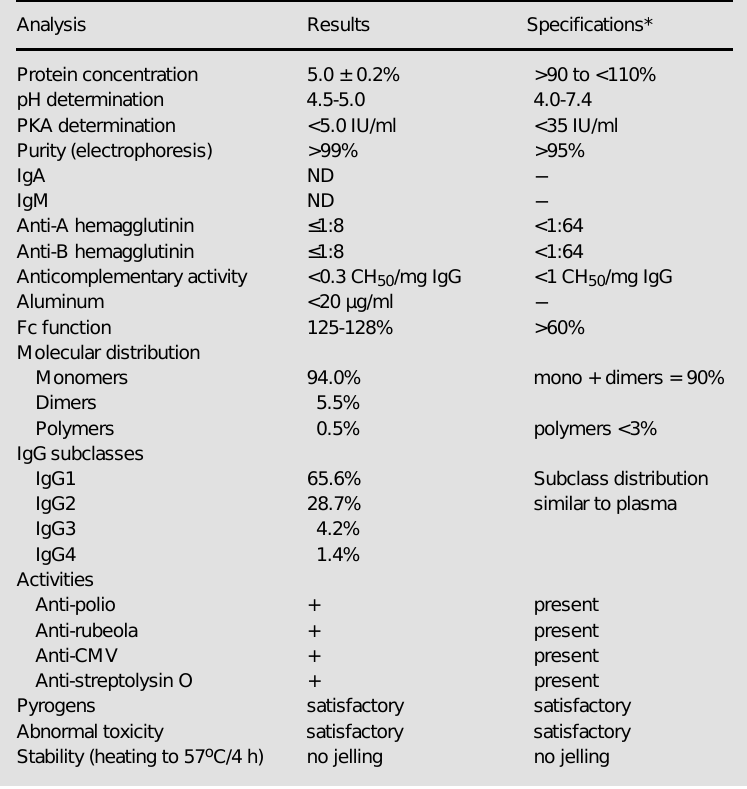
Table 2 - Characteristics of liquid intravenous